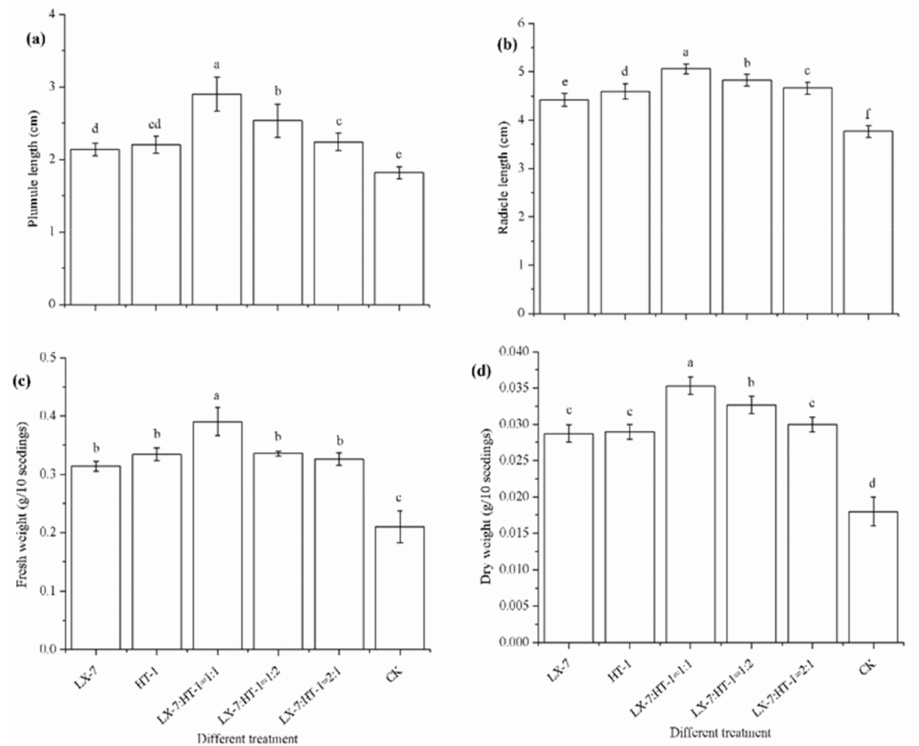
Figure 4. Effects of HT-1 and LX-7 strains on plumule length ( a ), radicle length ( b ), fresh weight ( c ) and dry weight ( d ) of Brassica chinensis L. seedlings. Values are mean ± SD (n = 30 seedlings). Different letters above the bars indicate the differences are significant at p <